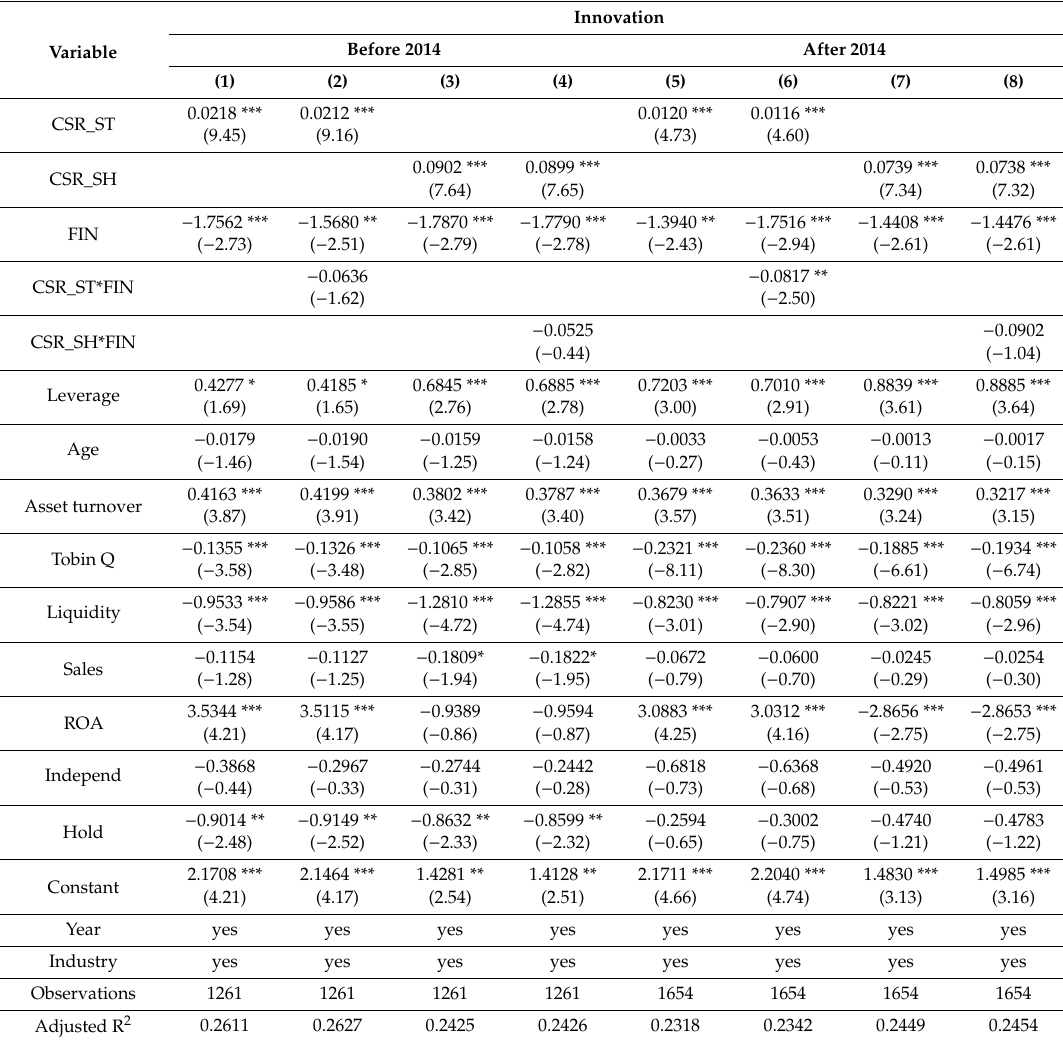
Table 11. Di ff erent CSR engagements in di ff erent